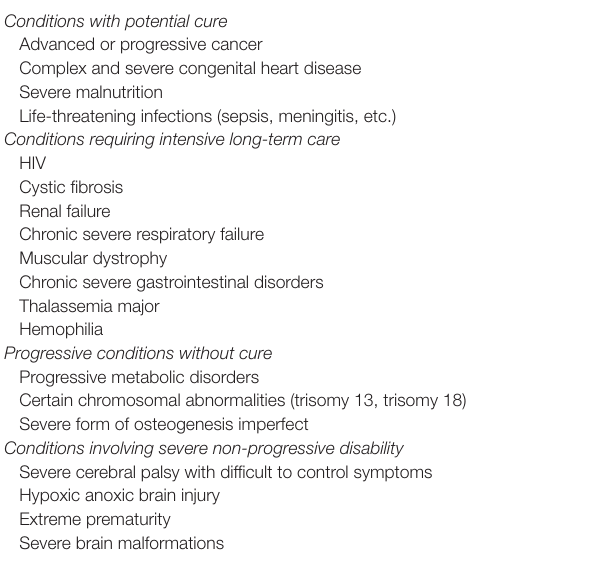
taBLe 1 | The conditions that could benefit from interdisciplinary palliative team approach.